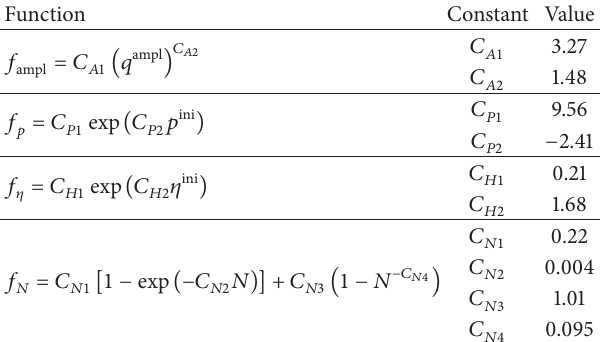
Table 2: Summary of the material constants. Function Constant